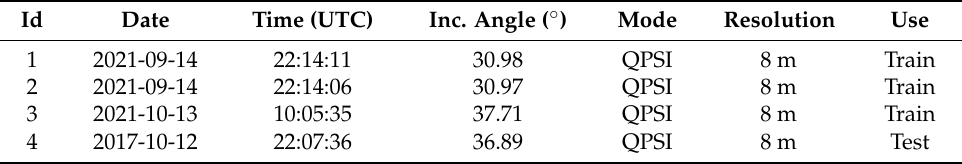
Table 1. Experiment